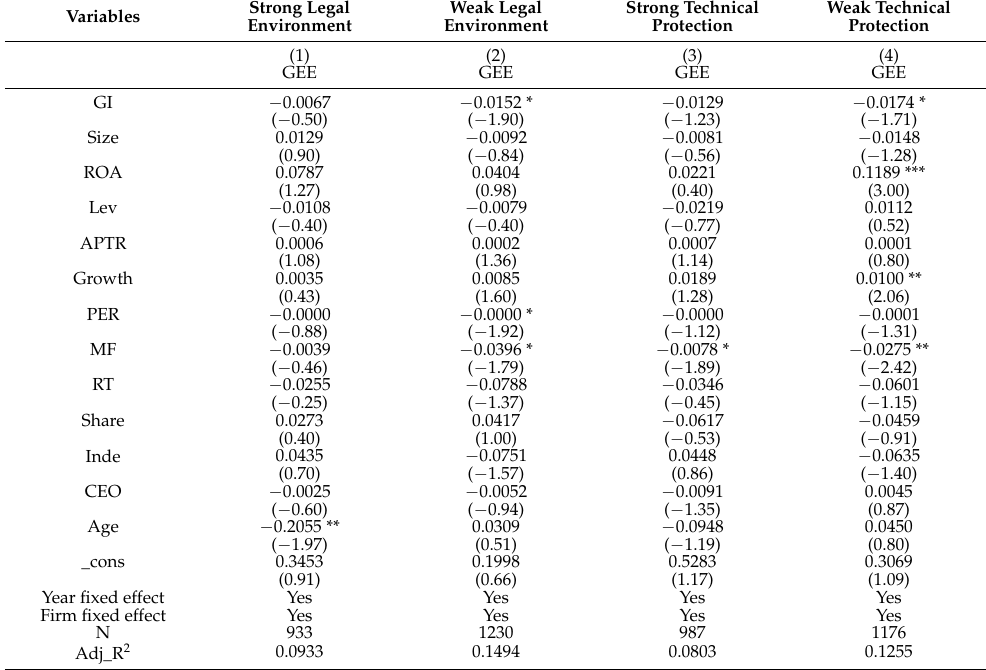
Table A13. Influence of the degree of protection of innovation achievements (Full version of Table 6).